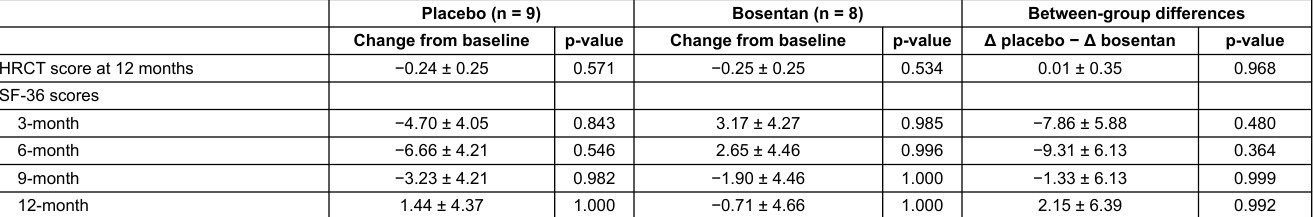
Table 3: Within-patient change from baseline in high resolution computed tomography (HRCT) score and the Medical Outcomes Study Short Form 36 (SF-36) questionnaire score. Placebo (n = 9) Bosentan (n = 8) Between-group